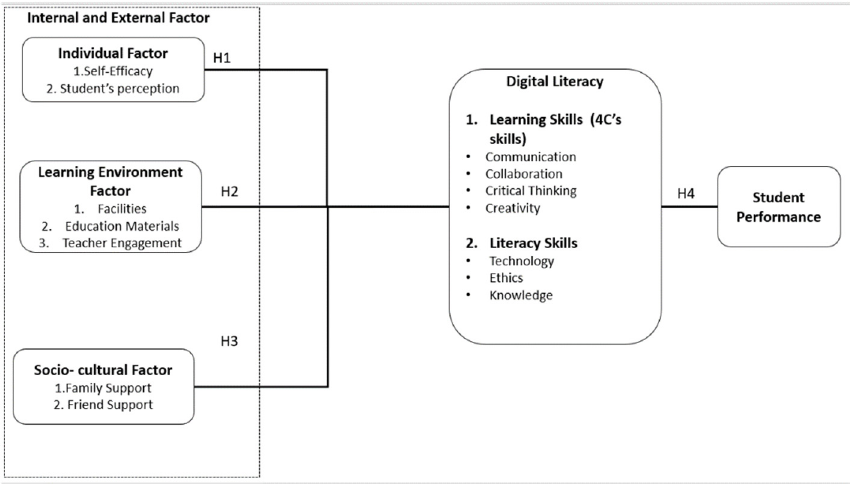
Figure 1. Research Framework.